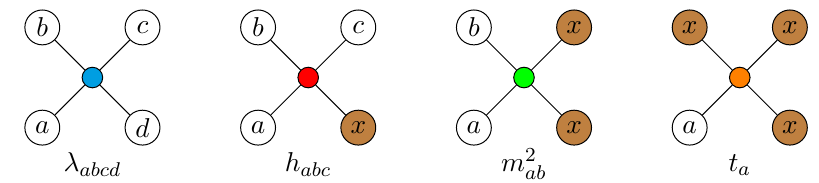
Figure 1 . Representation of vertices corresponding to the parameters of the Lagrangian (1.1). The index “ x ” denotes the contraction with a dummy